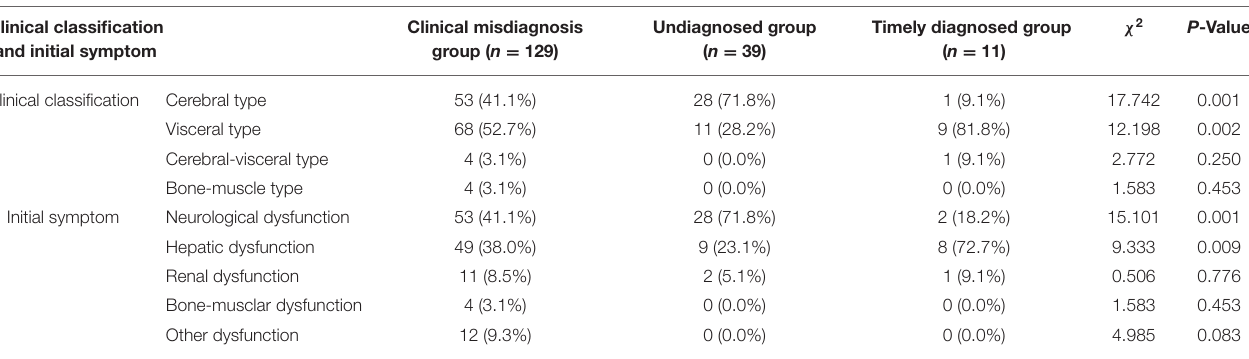
TABLE 2 | Comparing clinical classification, initial symptoms among three groups. Clinical classification and initial